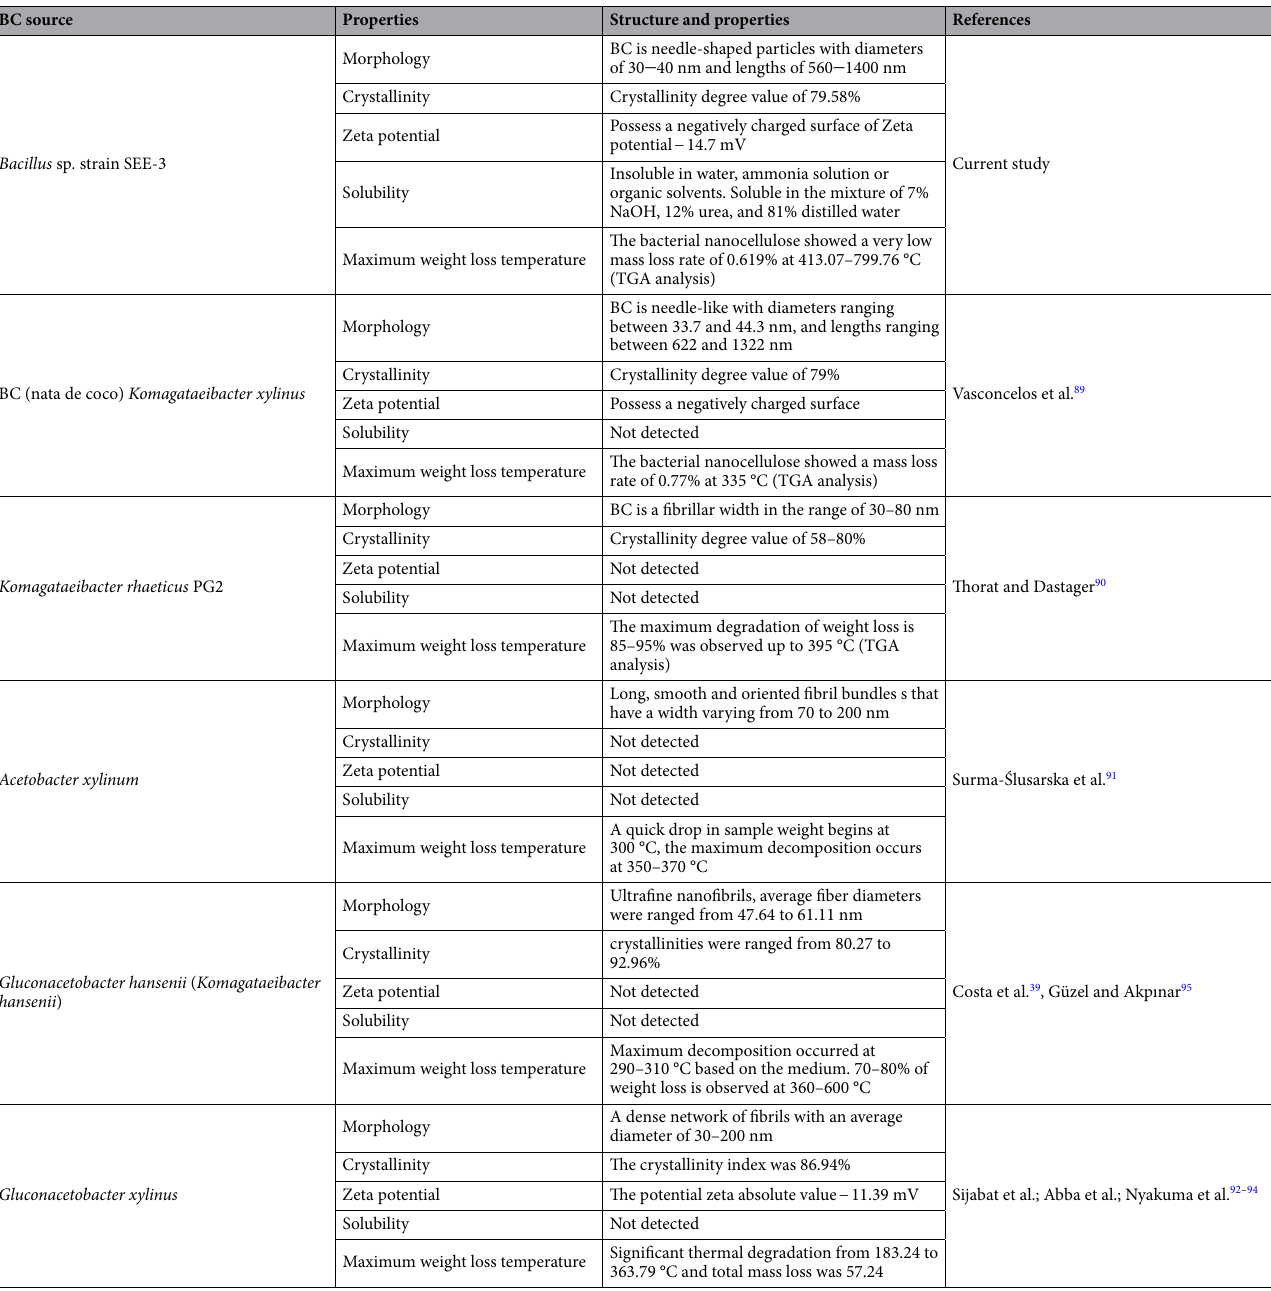
loss 98 . The third peak at 216.26 °C The fourth peak at 298.21 °C can be attributed to glass transition (T g ) and crystallization. The glass transition observed at 270 °C, and crystallisation observed at 330°C 98 . The glass transi- tion is the gradual and reversible transformation in amorphous solid region from a rigid and fairly glassy state into a rubbery and less viscous state with the rise in temperature. Mishra et al. 99 reported that the viscosity of an amorphous solid polymer decreased as the temperature increased, and at a certain temperature (crystallisa-